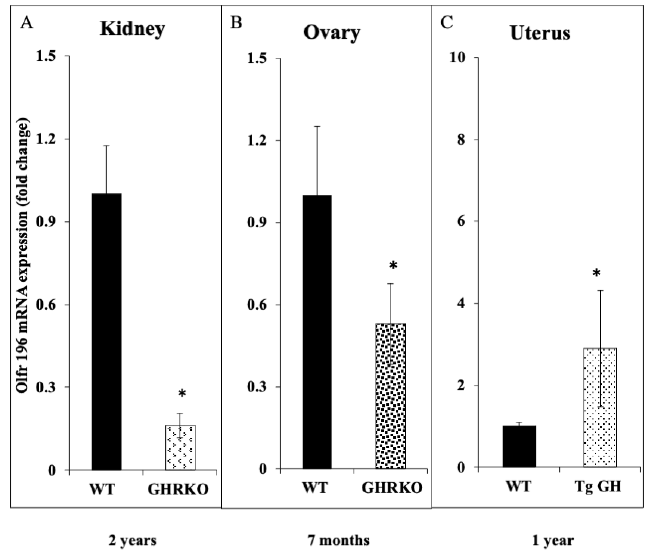
Figure 9. Expression of olfr196 mRNA in GHRKO and GH transgenic mice. Total RNA was pre- pared from the kidneys ( A ), ovaries ( B ) and uteri ( C ) of GHRKO ( A , B ) or GH transgenic ( C ) mice, or control littermates, and the olfr196 mRNA levels were measured by qPCR. Bars represent mean ± SD of 3 – 6 independent samples. *, p < 0.05 versus respective control.